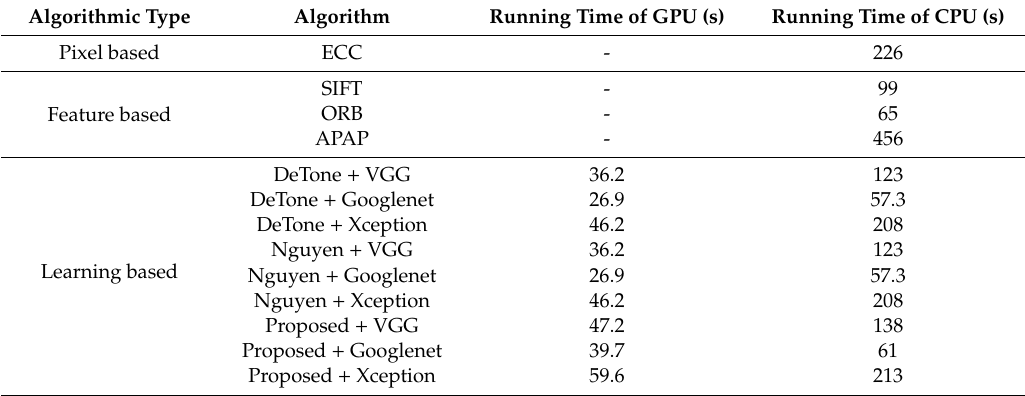
Table 2. Running time comparison of di ff erent image registration